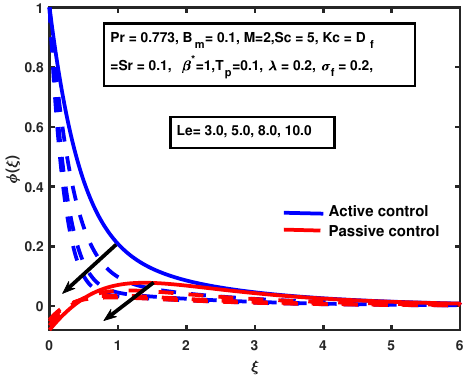
Figure 20. The impact of φ ( ξ ) on Lewis number Le